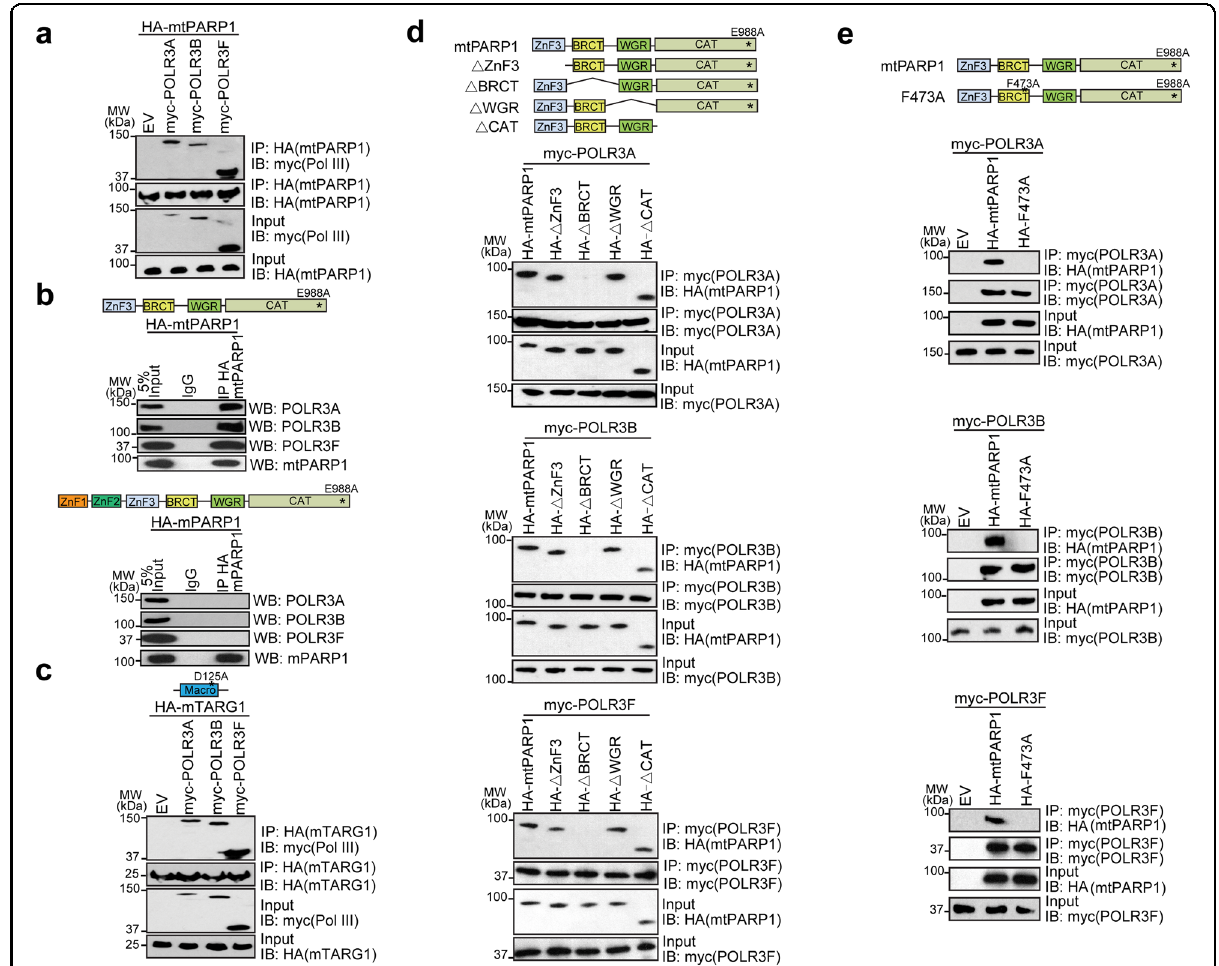
Fig. 2 The BRCT domain of tPARP1 interacts with the Pol III complex. a U2OS-PARP1 knockout cells were transfected with the myc-empty vector (EV), myc-POLR3A, myc-POLR3B, or myc-POLR3F together with HA-mtPARP1, followed by IP and western blotting with the indicated antibodies. b mtPARP1 or full-length mPARP1 was ectopically expressed in U2OS-PARP1 knockout cells. IP was performed with IgG as a negative control. c U2OS- PARP1 knockout cells were transfected with the myc-empty vector (EV), myc-POLR3A, myc-POLR3B, or myc-POLR3F together with HA-mTARG1, followed by IP and western blotting with the indicated antibodies. d U2OS-PARP1 knockout cells were transfected with the HA-tagged truncation mutants of mtPARP1 together with myc-POLR3A (upper panel), myc-POLR3B (middle panel), or myc-POLR3F (lower panel). e U2OS-PARP1 knockout cells were transfected with the indicated combinations of HA-tagged mtPARP1 or mtPARP1 F473A mutant together with myc-POLR3A (upper panel), myc-POLR3B (middle panel), or myc-POLR3F (lower